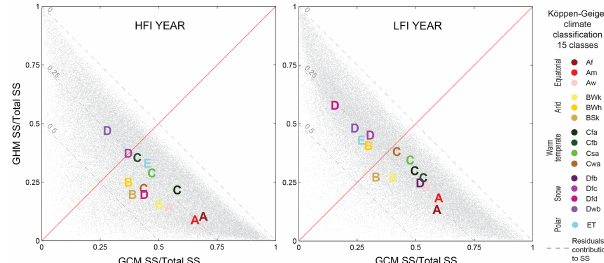
Figure 5. ANOVA sum of squares (SS) of the two factors (GHM y axis; GCM x axis) divided by the total sum of squares (TSS) for all grid cells as grey dots; and for each Köppen–Geiger climate region (15 most represented), as region letters shown at the medians of the region’s GCM SS/TSS as x -coord and of the regions’s GHM SS/TSS as y -coord.